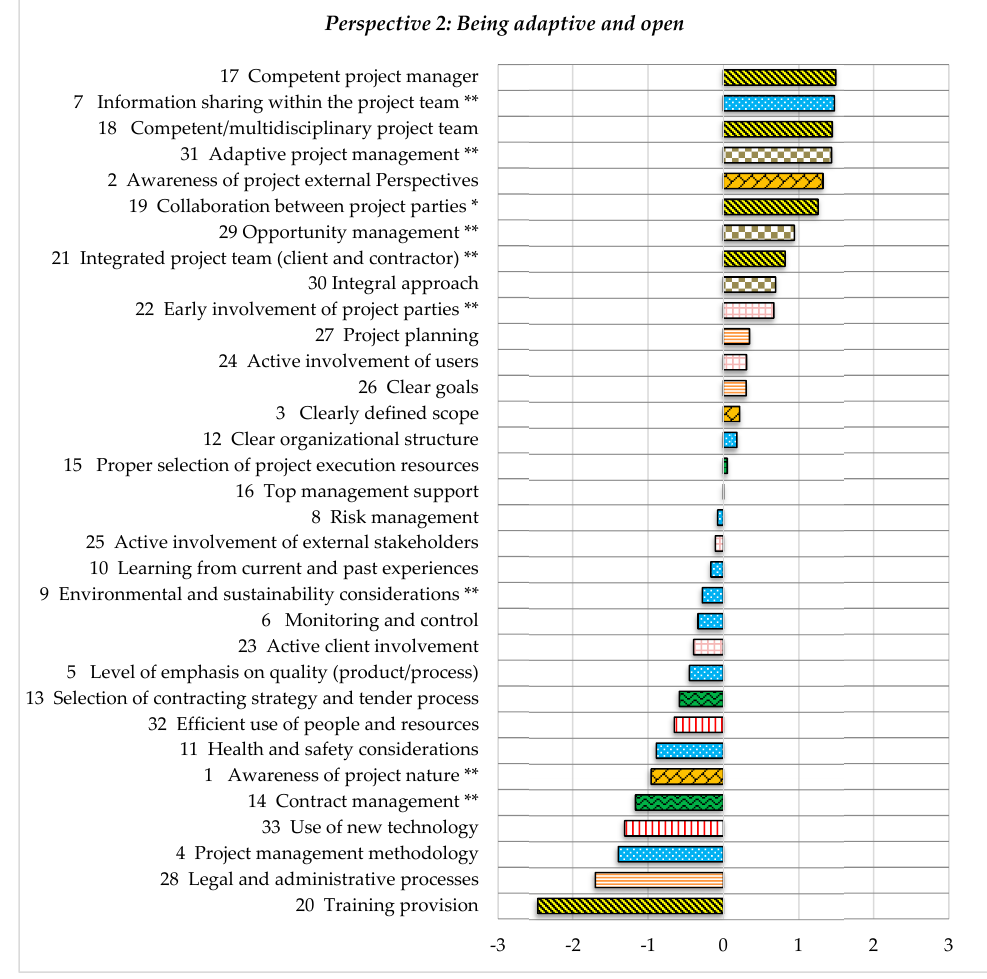
Figure 3. Ranking of success factors for being adaptive and open perspective (P2). * The factor is distinguishing at p < 0.05; ** The factor is distinguishing at p < 0.01.